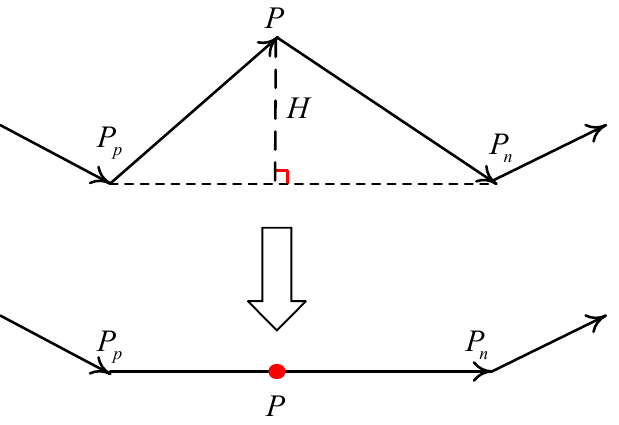
Figure 1. Track triangle for checking the drift track Figure 1. T rack triangle for checking the drift track points.